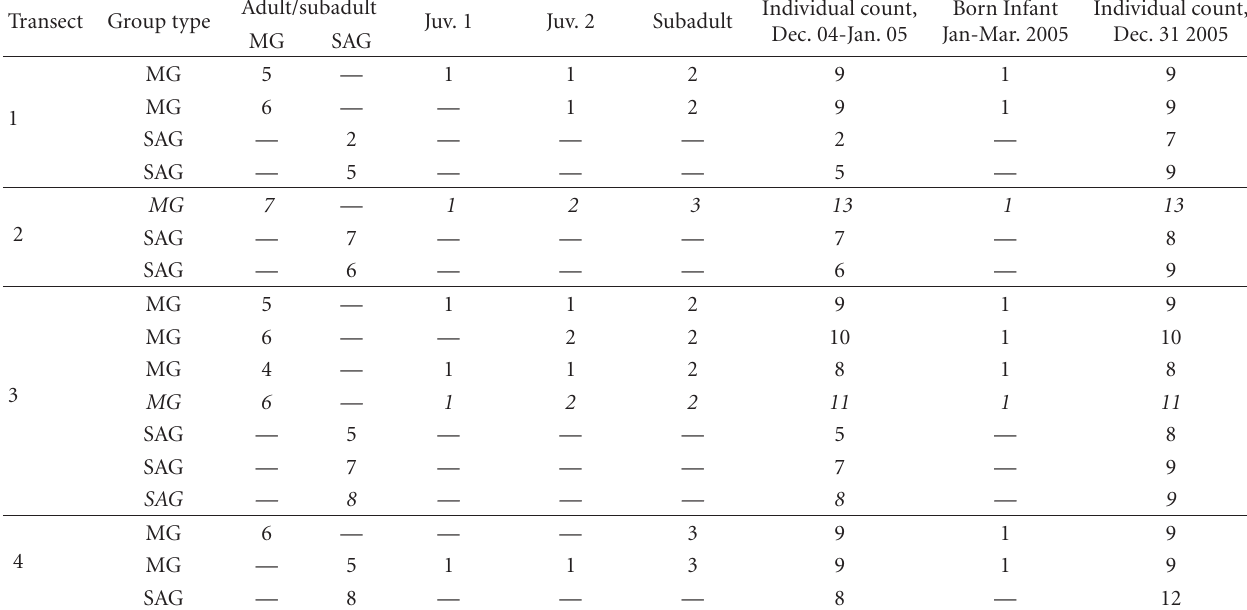
Table 1: Group composition of P. c. chrysomelas in the Samunsam Wildlife Sanctuary, (December 2004–December 2005) (MG = main group, SAG = subadult group). Three groups (italic) were consistently followed during research period. Transect Group